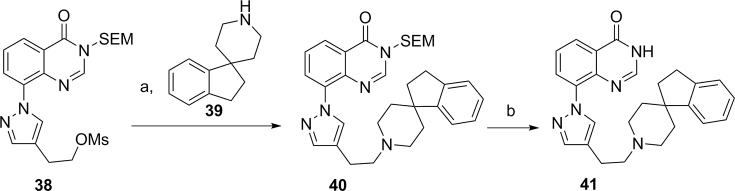
aReagents and conditions: (a) triethylamine, anhydrous DMF, 50 °C, 15 h; (b) 6 M HCl, THF, 50 °C, 3 h.